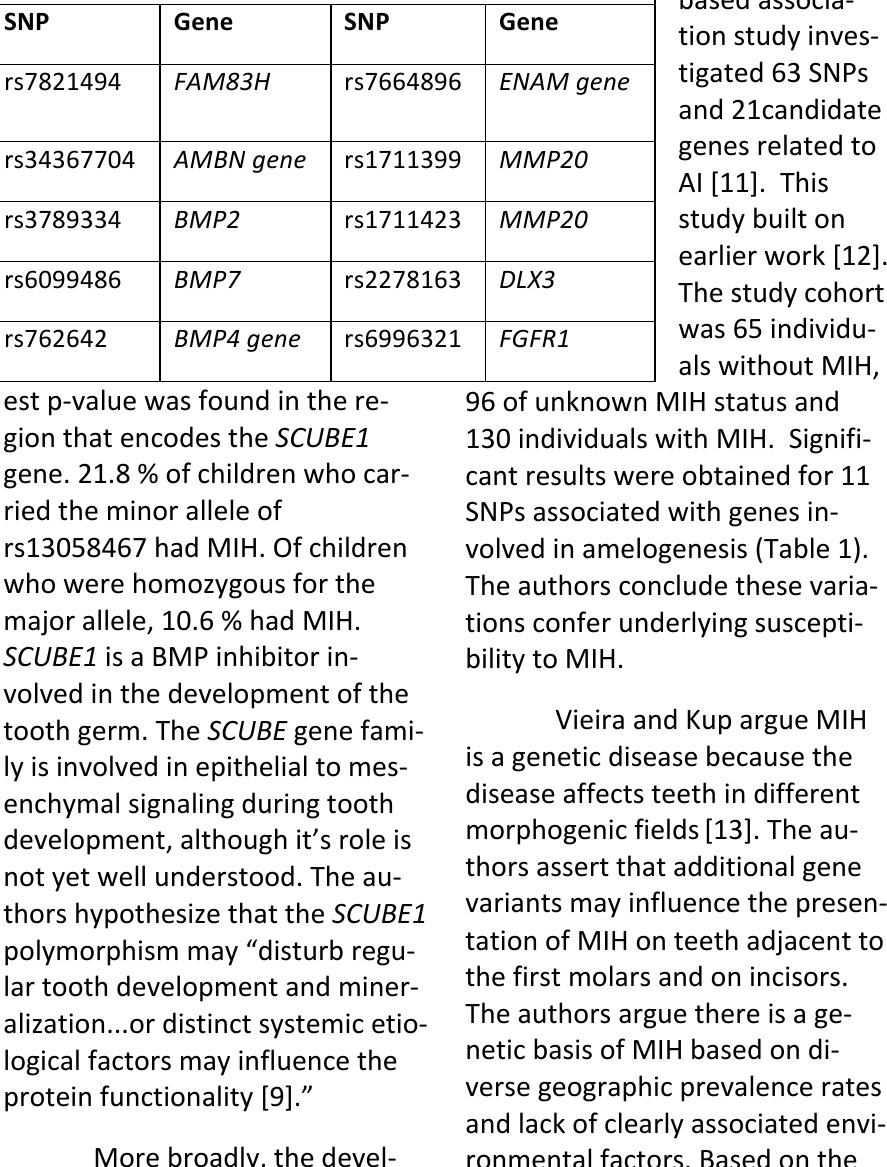
Table 1. SNPs and genes involved in amelogenesis SNP